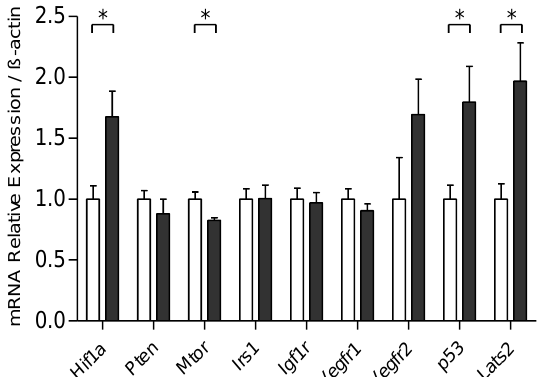
Figure 3. Physical exercise modulates the expression of genes related to glycolytic metabolism but not lactate concentration in tumor tissue of TNBC (4T1 cells). ( A ) Relative expression of genes related to glucose metabolism. Ldha (1), lactate dehydrogenase A isoform 1; †Ldha (2), lactate dehydrogenase A isoform 2; Mct-1, monocarboxylate transporter 1; † Mct-4, monocarboxylate transporter 4; HKII, hexokinase II; Pdk, pyruvate dehydrogenase kinase; Glut-1, glucose transporter type 1; β -actin, housekeeping. SED + SED n = 6; EXE + EXE n = 6. † group SED + SED n = 4; group EXE + EXE n = 4. ( B ) Lactate concentration in tumor tissue. SED + SED n = 7; EXE + EXE n = 7. White bars = SED + SED, black bars = EXE + EXE. Unpaired t -test, Means ± SEM. * p < 0.05.